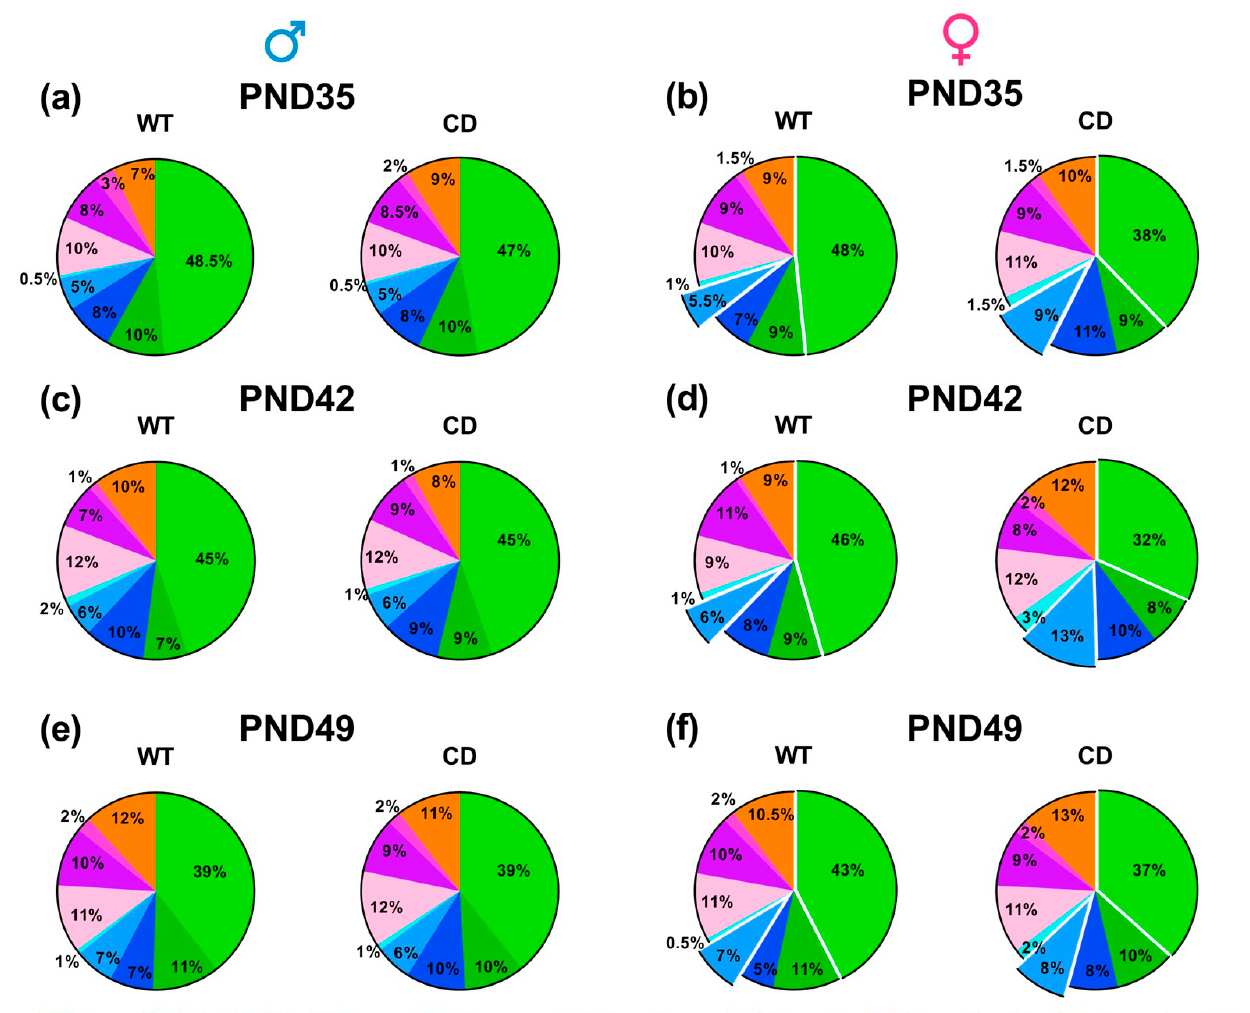
Figure 8. Call type composition of USVs emitted by juvenile mice. Call types were categorized using the software Sonotrack as described in detail elsewhere [31,37,38]. PND = post-natal day. Call categories that differed in CD females ( b , d , f ) are marked as detached from the remaining types. No differences were detected in males ( a , c , e ).